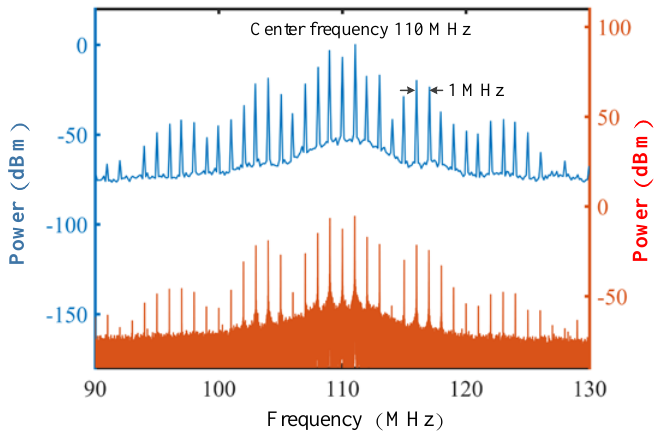
Figure 2. Beat notes between the signal source and the local oscillator. The blue line is measured by a spectrum analyzer with the left vertical axis; the red line is the result of Fourier transforming the waveform obtained by the oscilloscope with the right vertical axis.